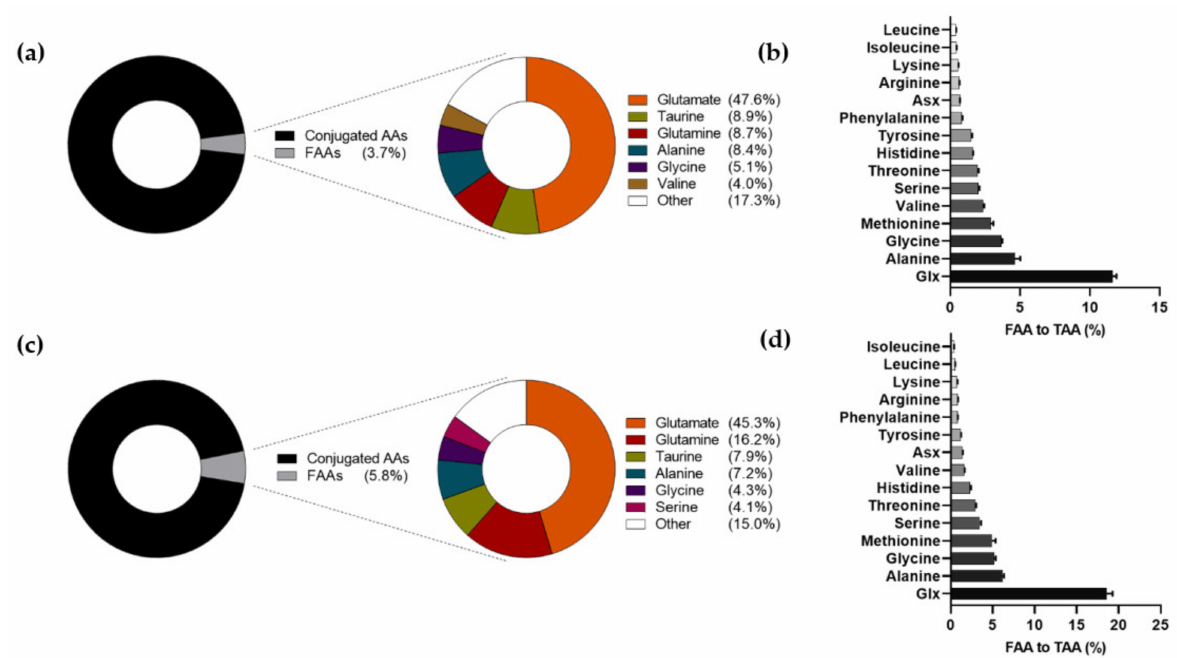
Figure 1. Relative abundance of individual free amino acids (FAAs) in human milk (HM) to the sum of FAAs and to the total amino acid (TAA) level of the corresponding amino acid in 6-week HM (( a , b ), respectively) and 6-month HM (( c , d ), respectively). Error bars show the 95% CI of the means. AA: amino acid; FAA: free amino acid; TAA: total amino acid; Asx: